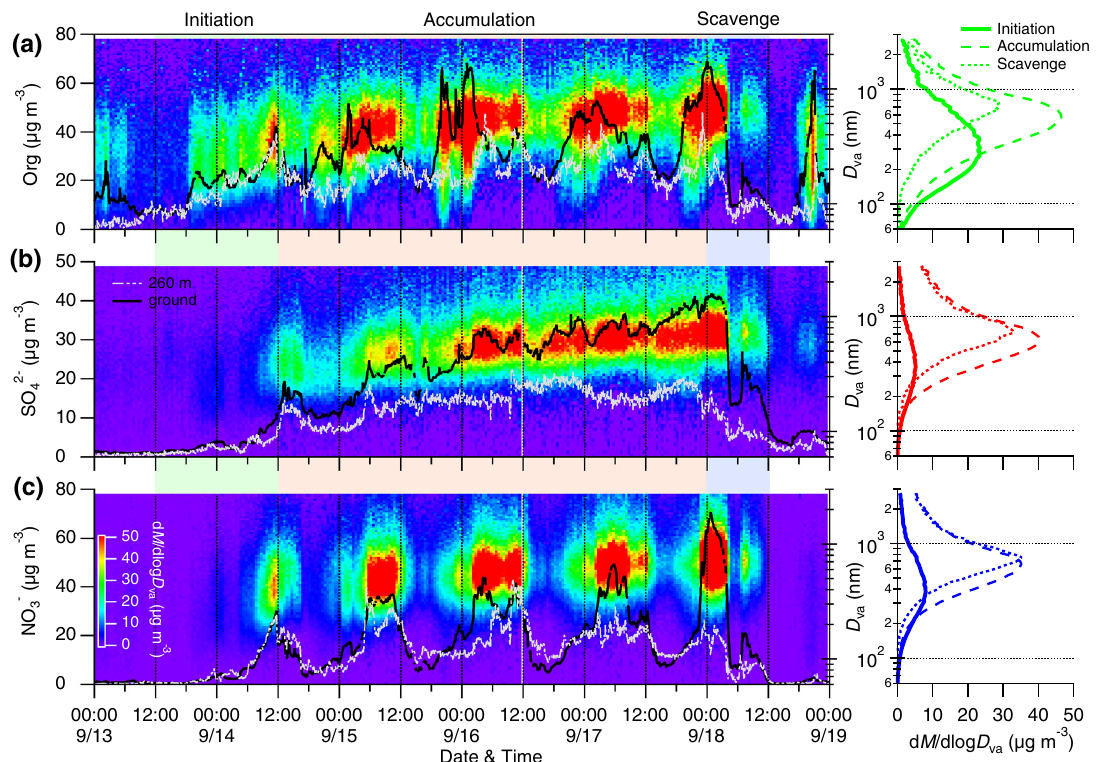
Fig. 2 Chemical compositions of submicron aerosols during haze pollution. The left panels show the evolution of total mass concentrations of a organics (Org), b sulfate (SO 42 − ), c nitrate (NO 3 − ) at 260 m (white line) and ground level (black line) during the typical NPF event followed by a severe haze episode. Size-resolved mass concentrations of Org, SO 42 − , and NO 3 − measured at ground level by high-resolution time-of- fl ight aerosol mass spectrometer are also shown. The right panels show the average mass size distributions of Org, SO 42 − , and NO respectively, for the three periods, i.e., initiation (September 13 midday – September 14 midday, 2015), accumulation (September 14 midday – September 18 midnight, 2015), and scavenge (September 18 midnight – September 18 midday, 2015).